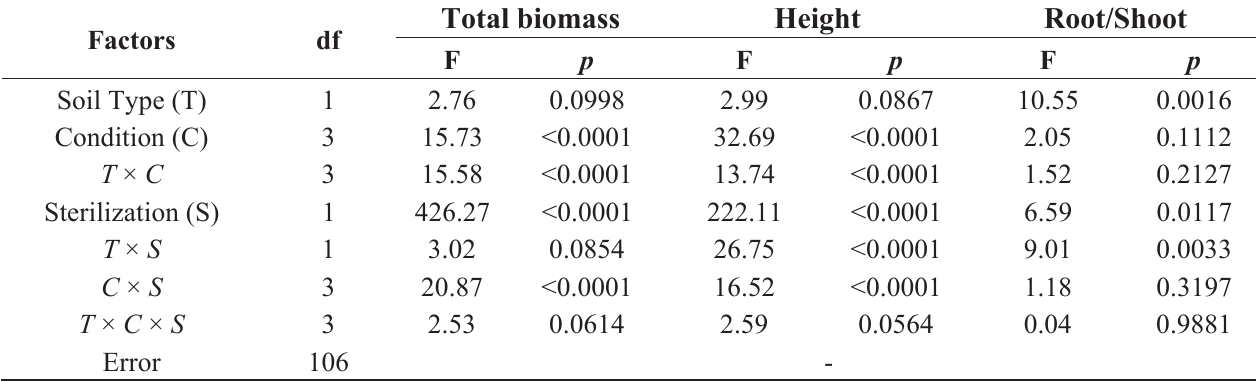
Table 4. Results of three-way ANOVA of soil type, soil conditioning, and soil sterilization on total biomass, root/shoot ratio, and height of Diervilla lonicera